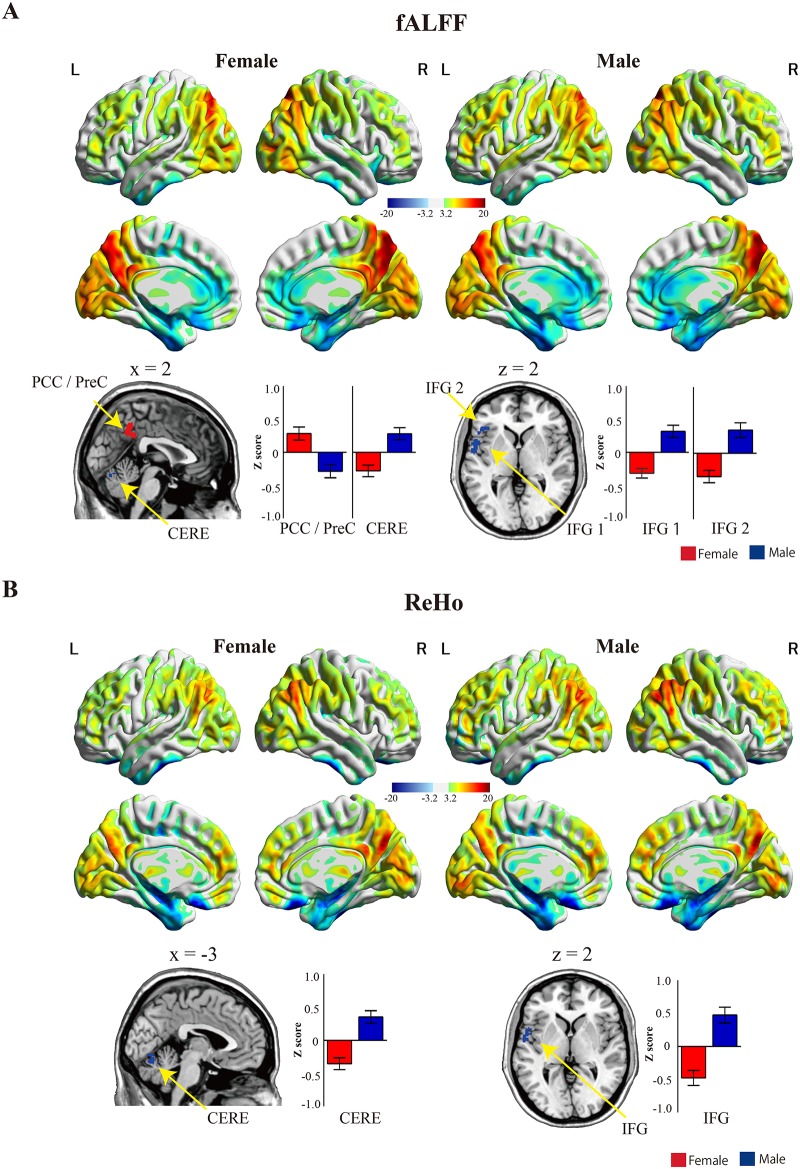
Regional measure results.(A) fALFF Z maps for females and males are shown on the left and right, respectively. Females showed significantly stronger fALFF results in the PCC/PreC compared with males, but males fALFF results were stronger in the CERE and IFG. The maps depict the statistical threshold at p < 0.001 uncorrected for height and a cluster at p < 0.05 uncorrected for extend. Color bars denote the t-statistic range. CERE, cerebellum; IFG, inferior frontal gyrus; L, left; PCC, posterior cingulate cortex; PreC, precuneus; R, right. (B) ReHo fALFF Z maps for females and males are shown on the left and right, respectively. Males showed significantly stronger ReHo results in the CERE and IFG compared with females. The maps depict the statistical threshold at p < 0.001 uncorrected for height and a cluster at p < 0.05 uncorrected for extend. The bar graph indicates the mean and standard error of Z scores in each group. The red and blue bars indicate females and males, respectively. Colored bars denote the t-statistic range. CERE, cerebellum; fALFF, fractional amplitude of low-frequency fluctuation; IFG, inferior frontal gyrus; L, left; PCC, posterior cingulate cortex; R, right; ReHo, regional homogeneity.